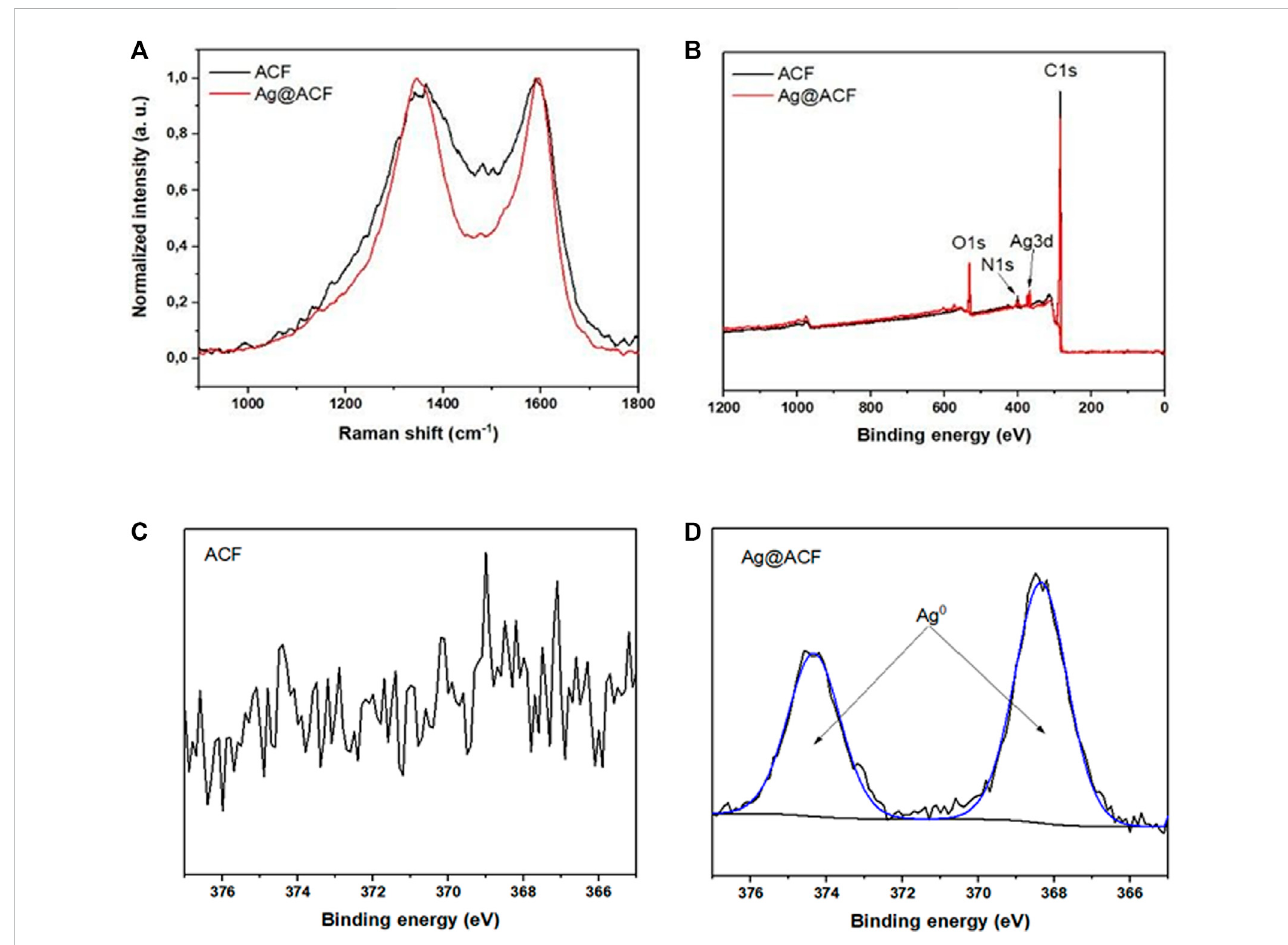
FIGURE 3 Spectral analyses: (A) Raman spectrum of ACF and Ag@ACF; (B) XPS spectra of ACF and Ag@ACF; (C) High resolution spectrum of ACF; and (D) Ag@ACF samples for Ag3d.